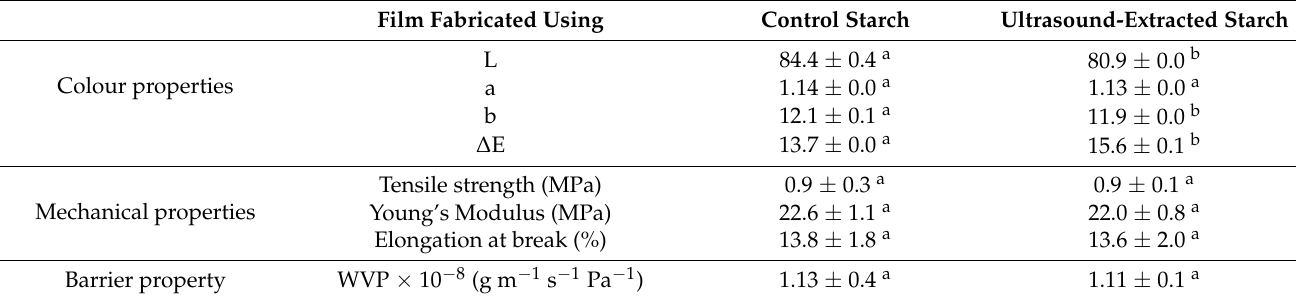
Table 3. Properties of film fabricated using control and ultrasound-extracted starches.